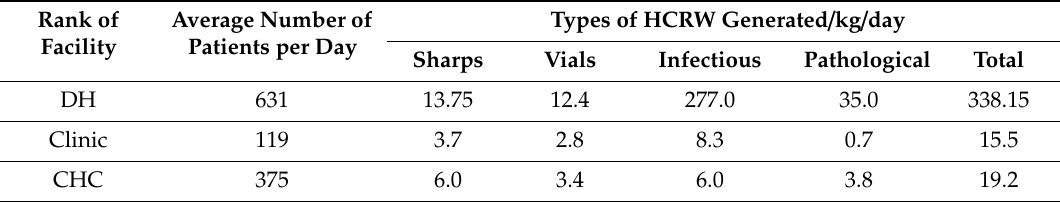
Table 2. Healthcare risk waste (HCRW) generation figures in Vhembe